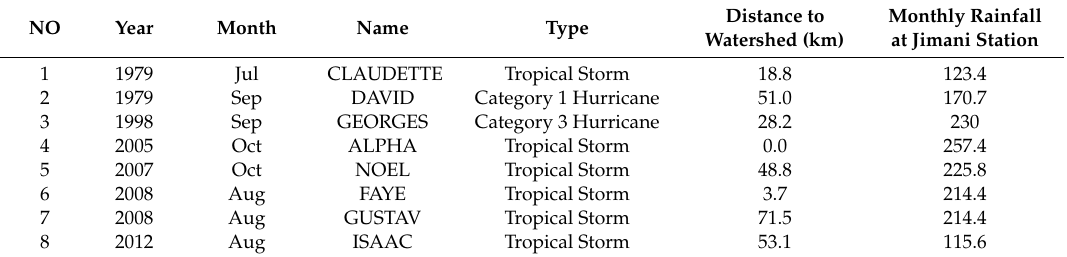
Table 5. Storm and hurricane incidents in 80km of the lakes’ watershed